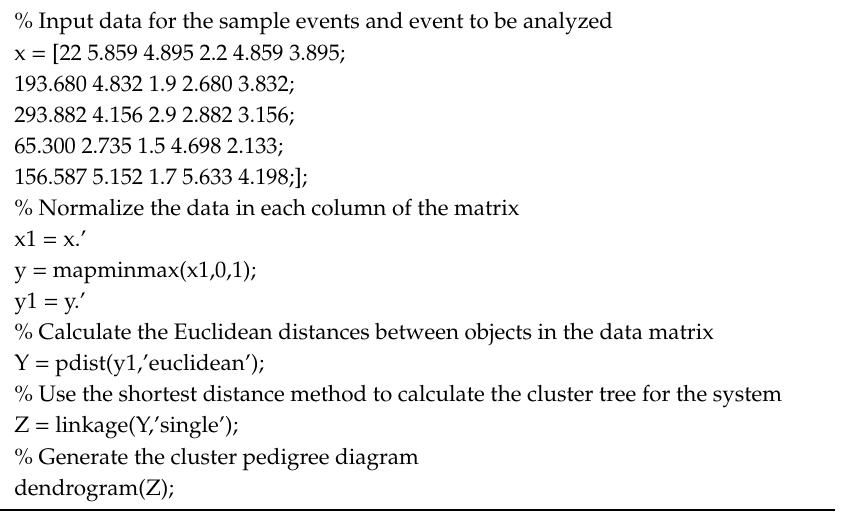
Algorithm A1 Pseudocode for the rockburst intensity warning procedure % Input data for the sample events and event to be